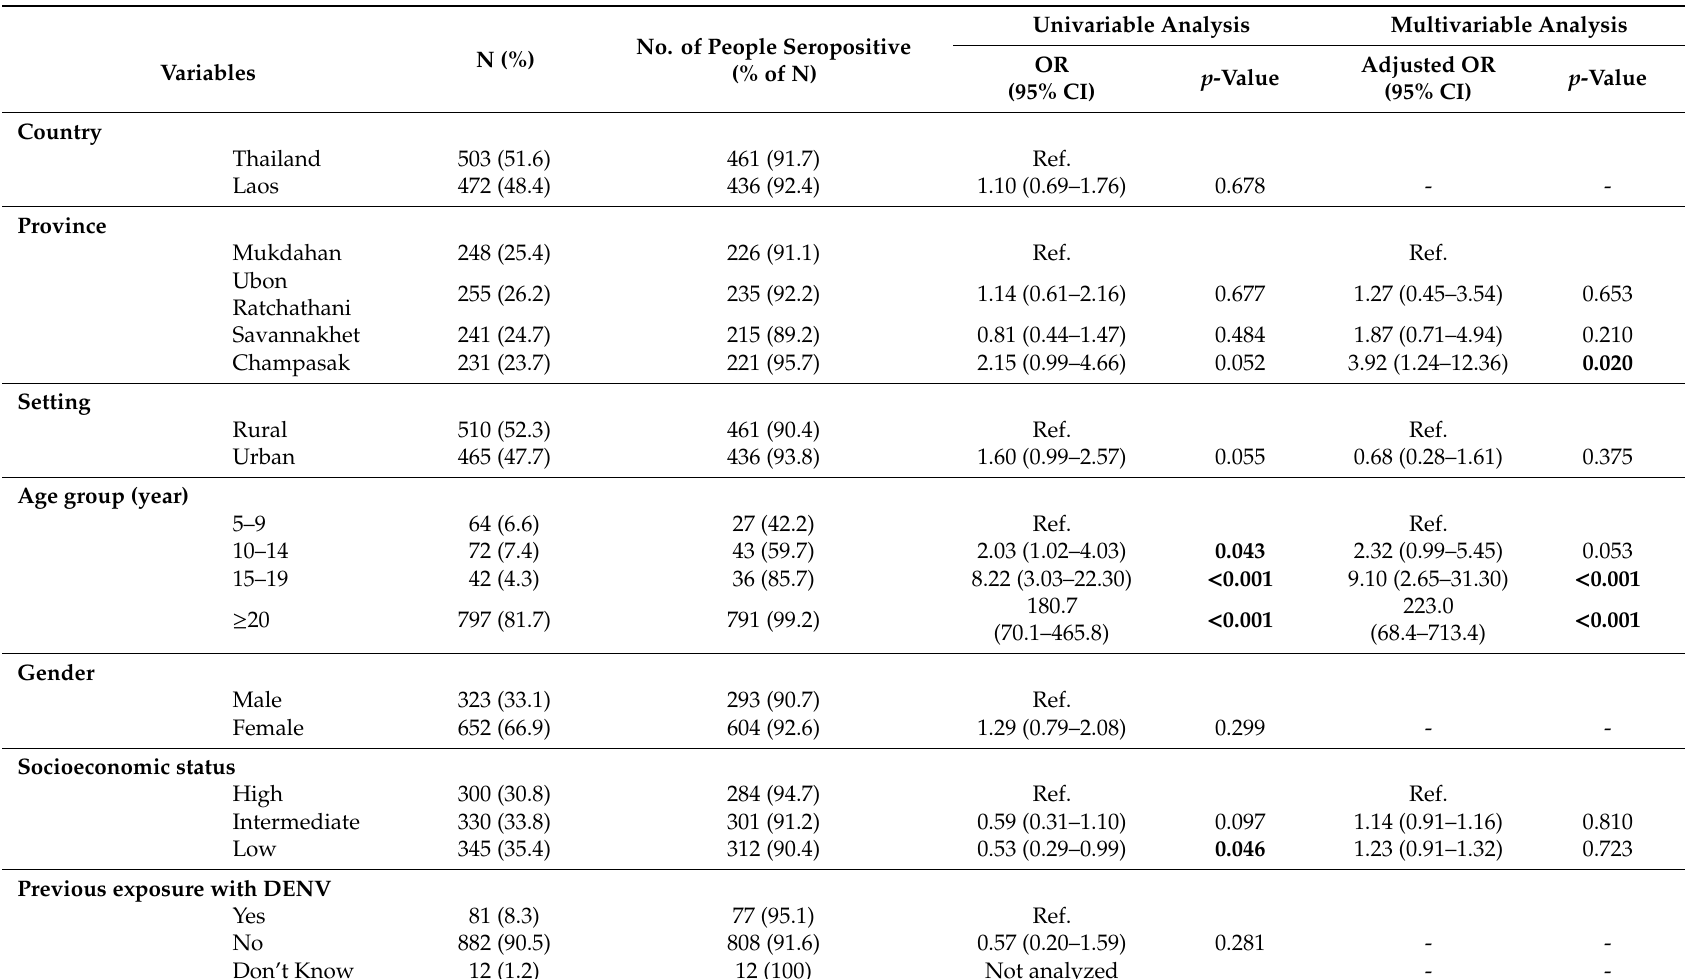
Table 2. Risk factors association with positive dengue antibody seroprevalence in May 2019 in Thailand and Laos (N =